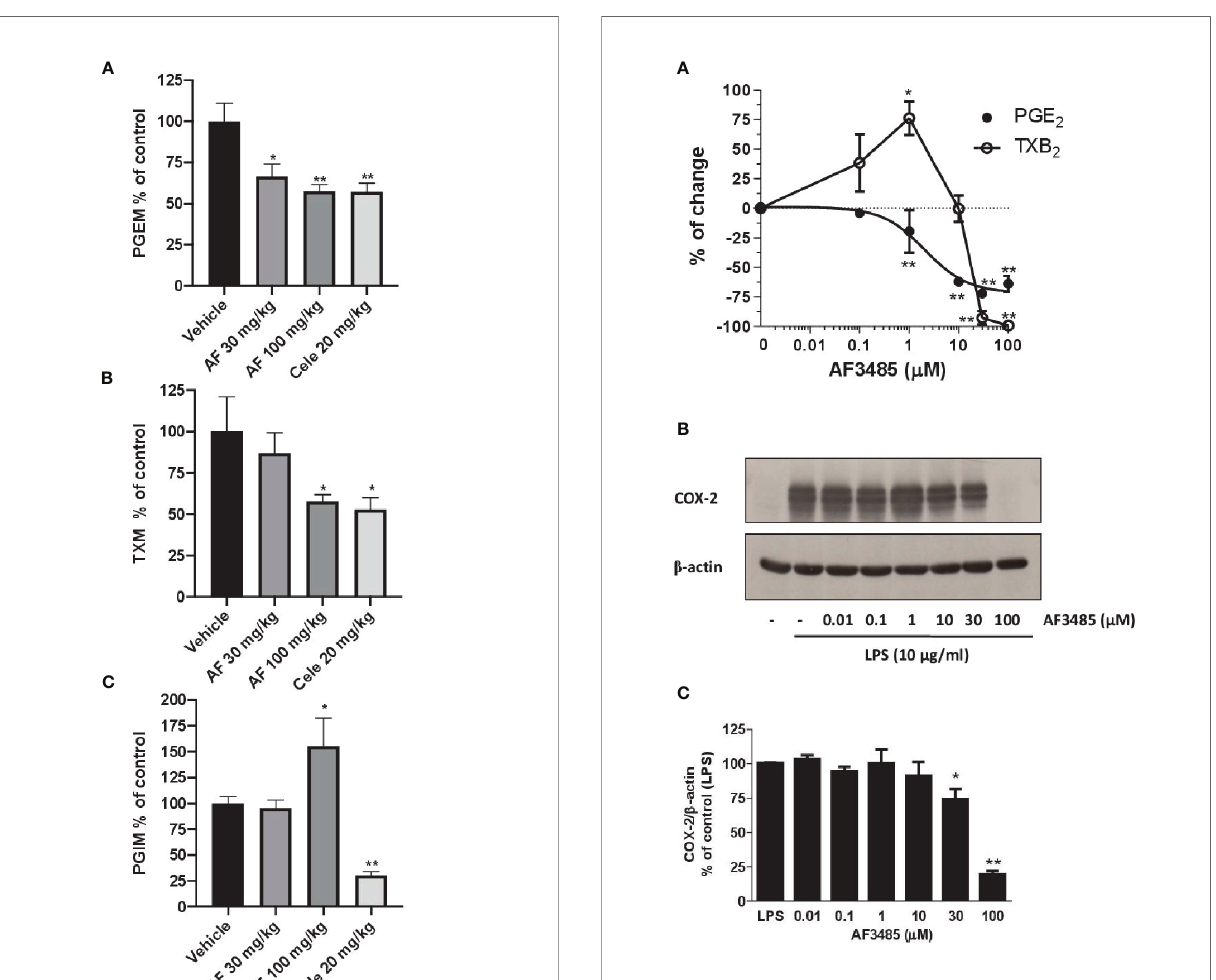
FIGURE 4 | Effects of AF3485 on prostanoid biosynthesis and COX-2 expression in LPS-stimulated monocytes. Increasing concentrations of AF3485 (0.01 – 100 µM) or DMSO vehicle were added to isolated human monocytes (1.5 – 2 x 10 6 cells/ml) in the presence of LPS (10 µg/ml) for 24 h at 37 °C. (A) PGE 2 and TXB 2 levels were measured in conditioned media by immunoassays. The data are reported as % of control (DMSO vehicle) (mean ± SEM, n=4 – 5). *P < 0.05, **P < 0.01 versus control (DMSO vehicle). (Student's t-test). (B) COX-2 was analyzed by Western blot; b -actin was used as protein loading control. The fi gure is representative of three different experiments. (C) Densitometric analysis of COX-2 expression; blots were normalized to b -actin and the data were reported as % of control (LPS), bars are mean ± SEM, n=3. *P < 0.05 and **P < 0.01 versus LPS (Student's t- test). PGE 2 , prostaglandin E